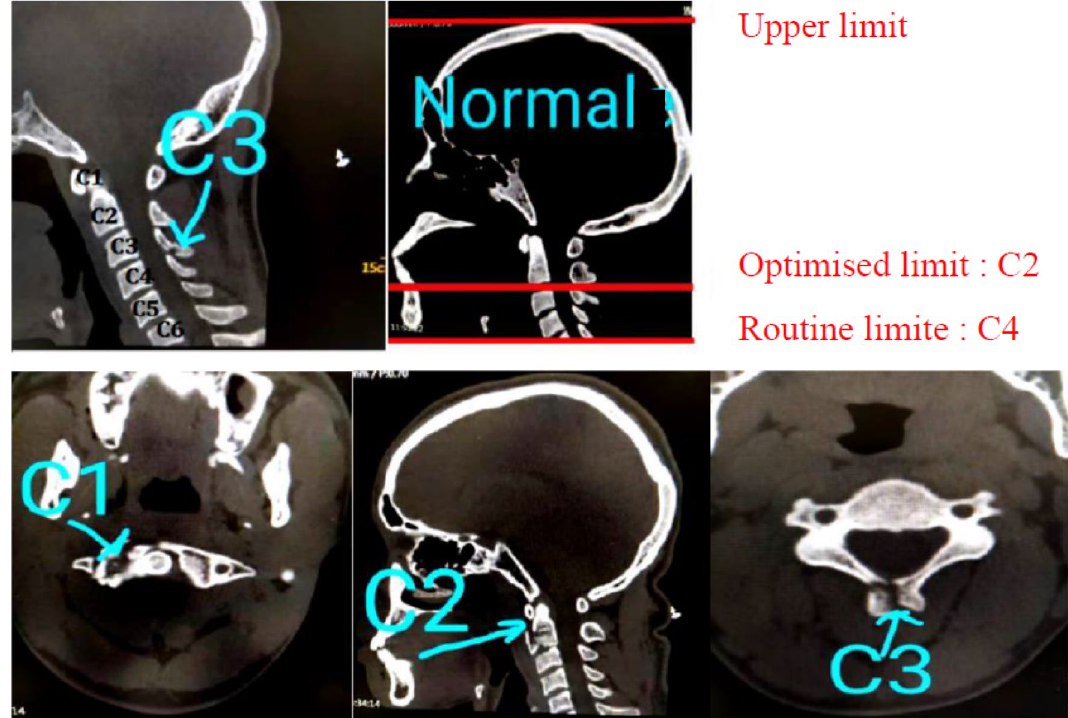
Figure 1. Optimized acquisition limit and position of fractures. Scan